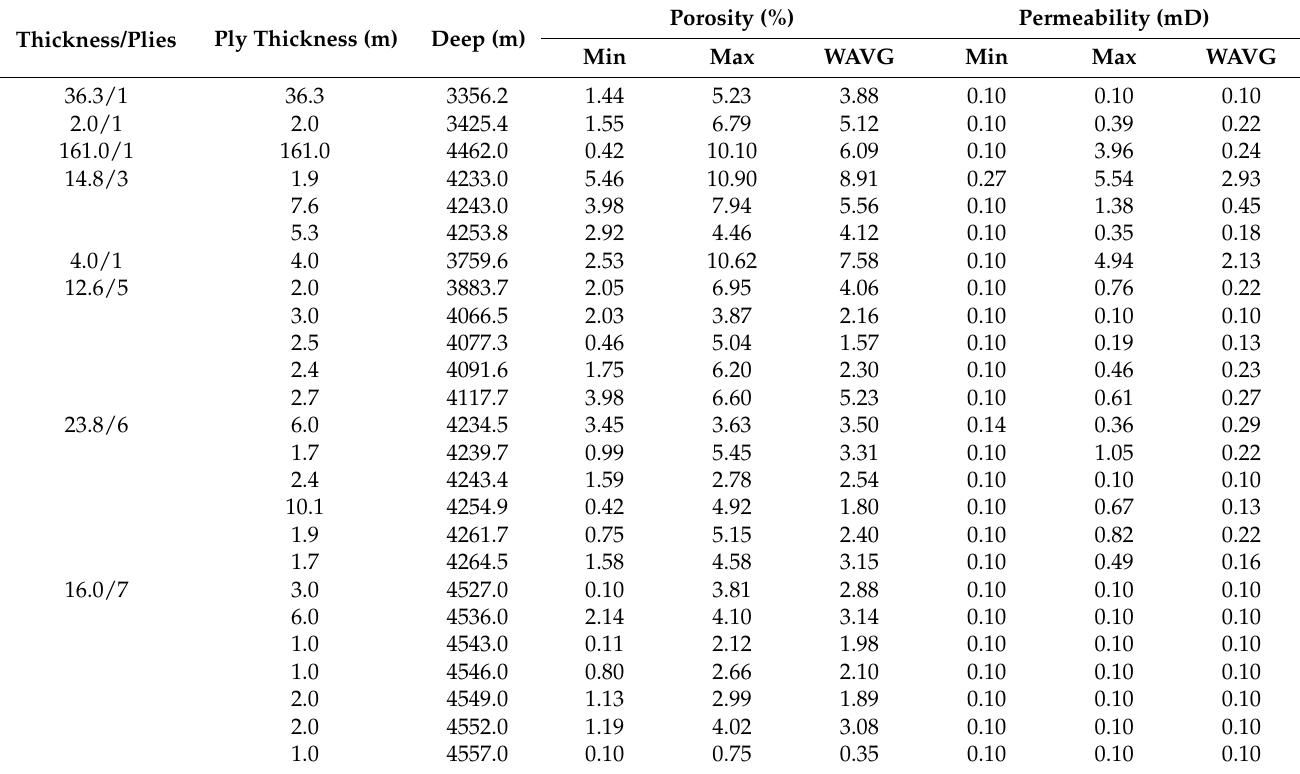
Figure 7. The variations of porosity ( a ) and permeability ( b ) with depth, corresponding to Table 4. Thick black lines indicate the fitted variational curves. Red shades indicate the abnormal overpressure zones. WAVG = Weighted-average data. Table 4. Well testing data of the Es 3L